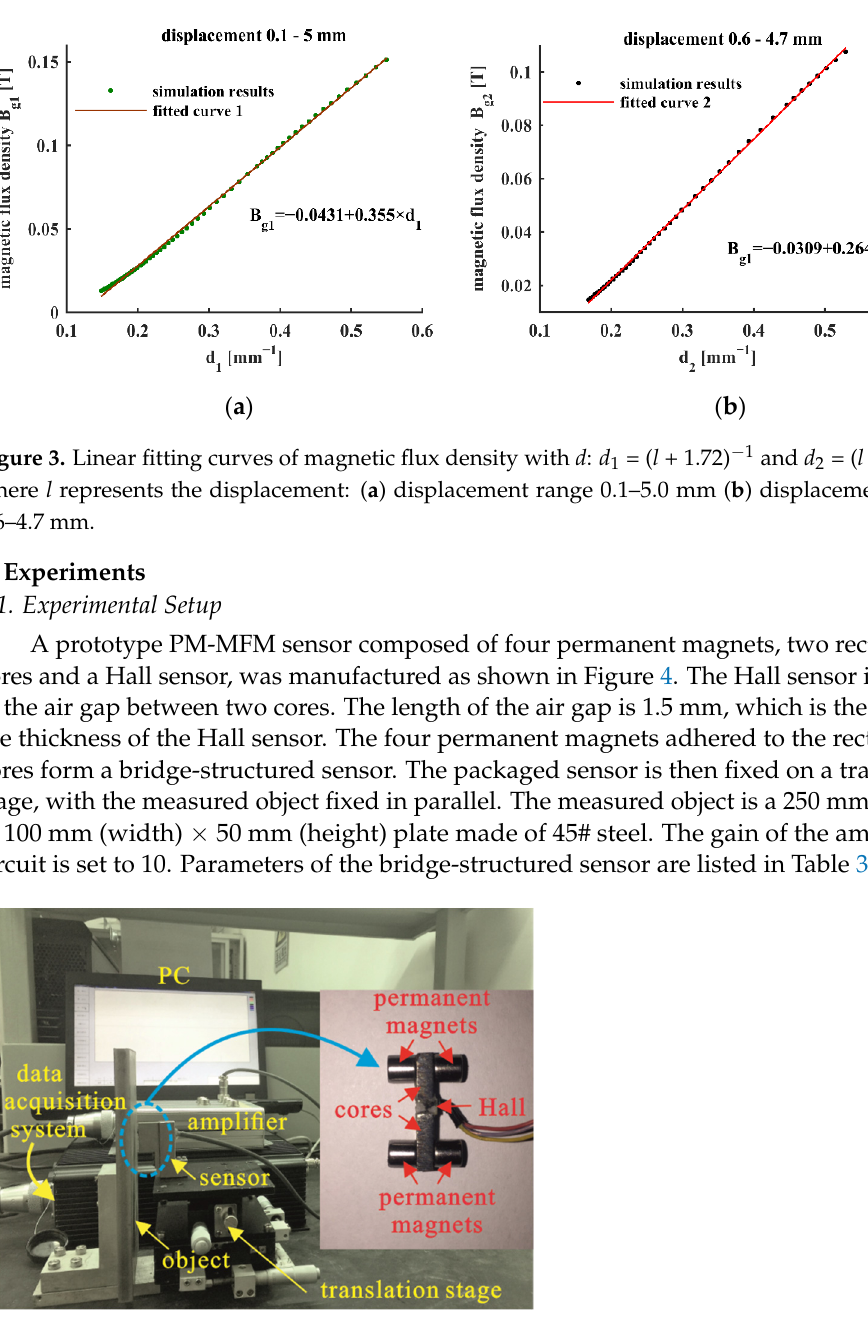
Figure 4. The experimental setup of the PM-MFM sensor; the inset shows the prototype PM-MFM sensor comprising four permanent magnets, two rectangular cores and a Hall sensor. Table 3. Parameters of the PM-MFM